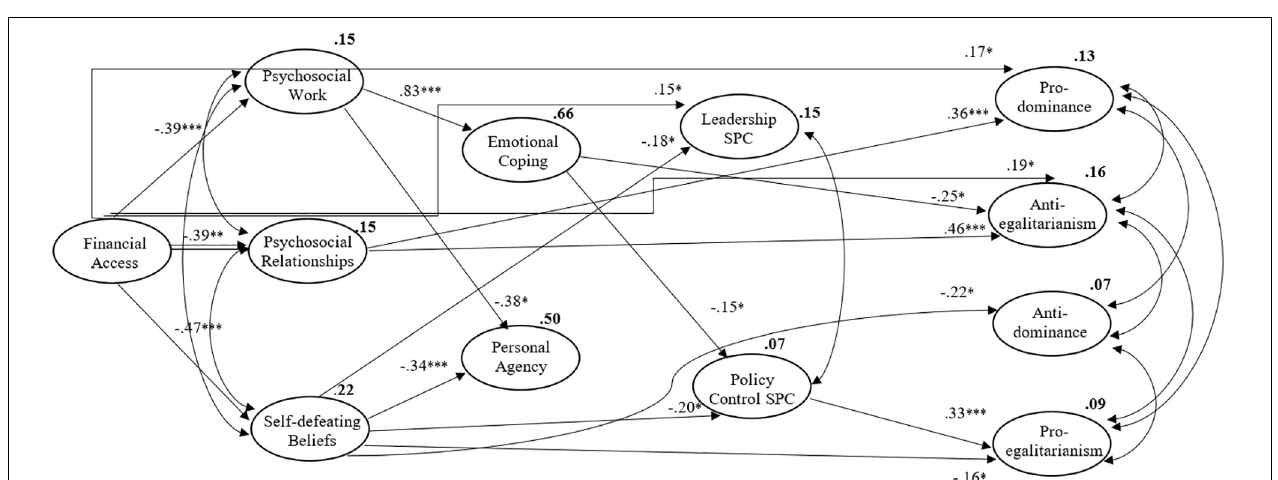
FIGURE 1 | Model A, representing all paths established.